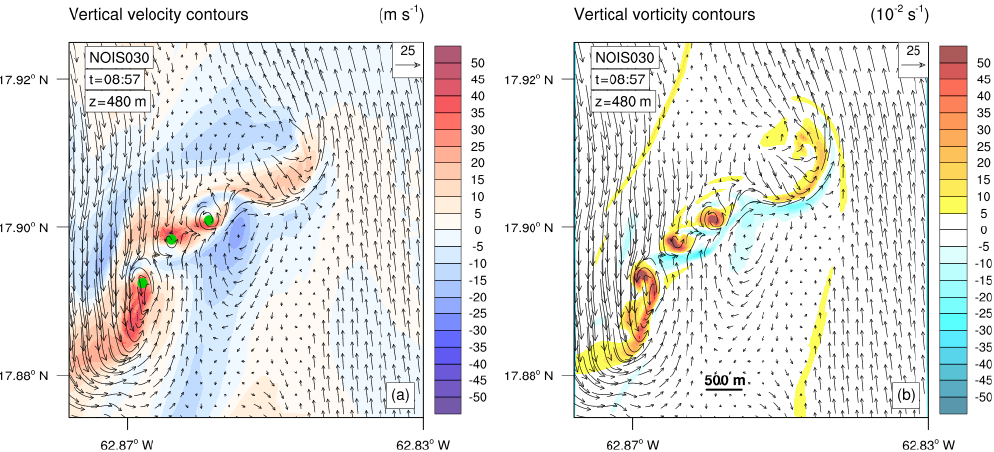
Figure 6. Tornado-scale vortices at 480m level linked with the maximum simulated gust occurring at 08:57UTC in NOIS030 dashed area (Fig. 4). (a) Perturbation vertical velocity contours (ms − 1 ). (b) Vertical vorticity contours (10 − 2 s − 1 ). Perturbation horizontal wind vectors are plotted in the two